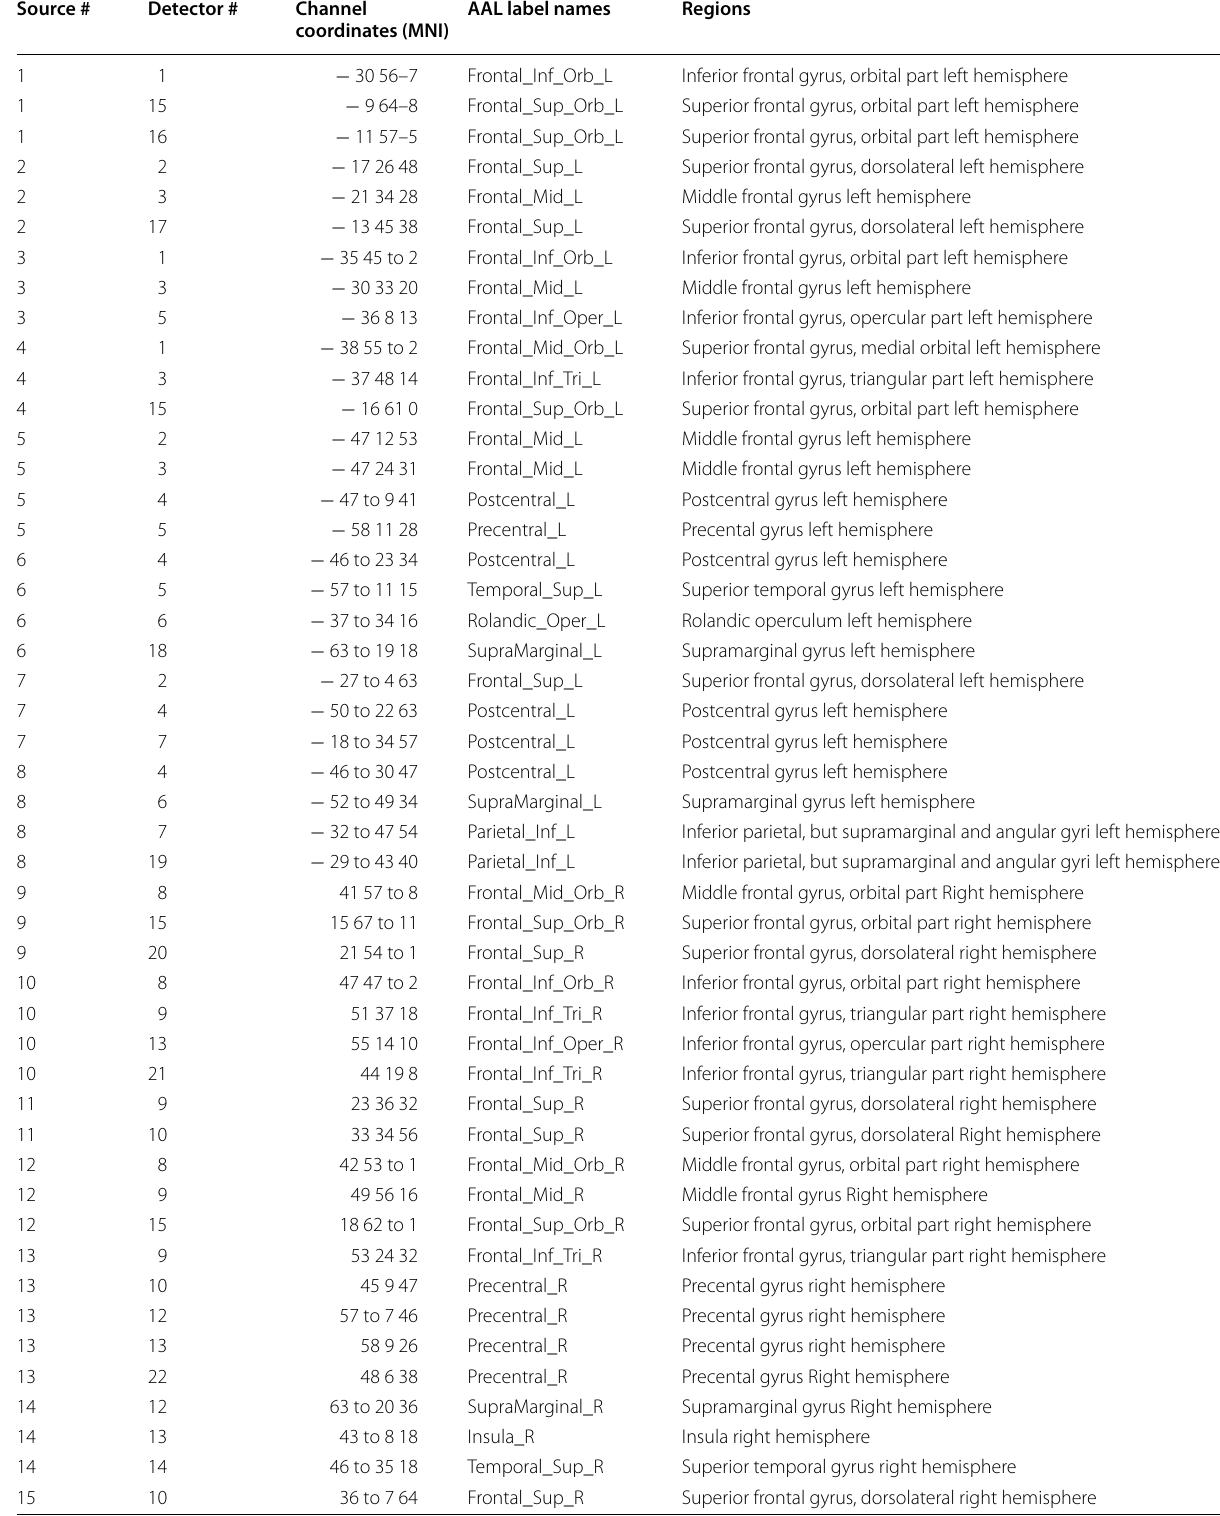
Table 1 Automated anatomical labeling (AAL) and Montreal Neurological Institute (MNI) coordinates of the cortical areas underlying fNIRS channels (source #–detector # pair) when projected on the cortex in AtlasViewer using its default head model